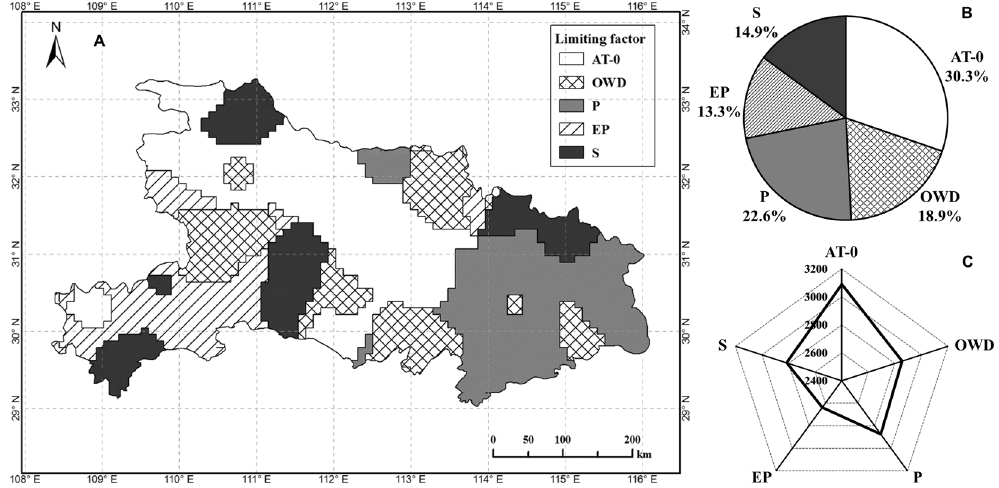
Figure 3. Spatial distribution ( A ) and proportion ( B ) of yield-limiting agroclimatic factors, and the attainable yield as predicted by the multivariate model. AT-0 mean ≥ 0 °C accumulated temperature, OWD mean overwintering days, P mean precipitation, EP mean precipitation at an earlier stage, S mean sunshine hours. Figure was created by ArcGIS Desktop (Version 9.3, URL: http://www.esri.com)